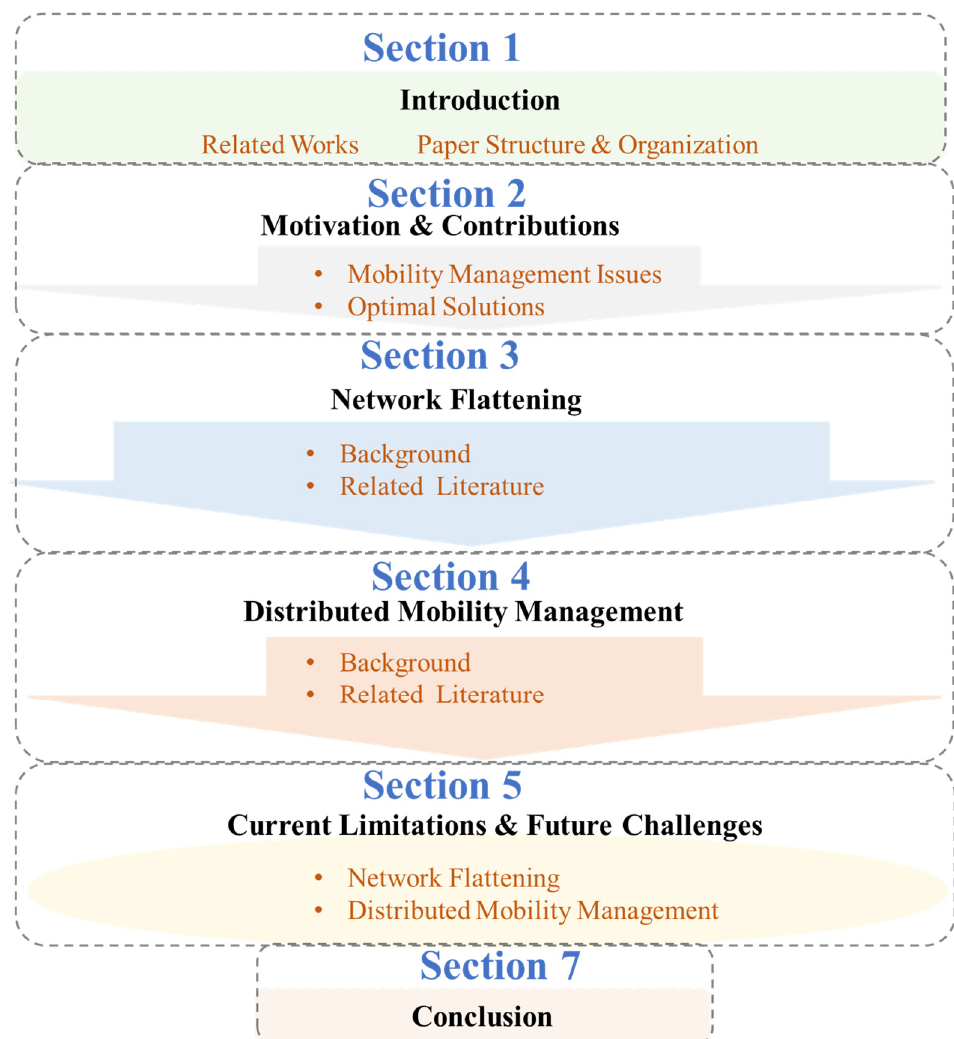
Figure 2. Paper structure and organization.